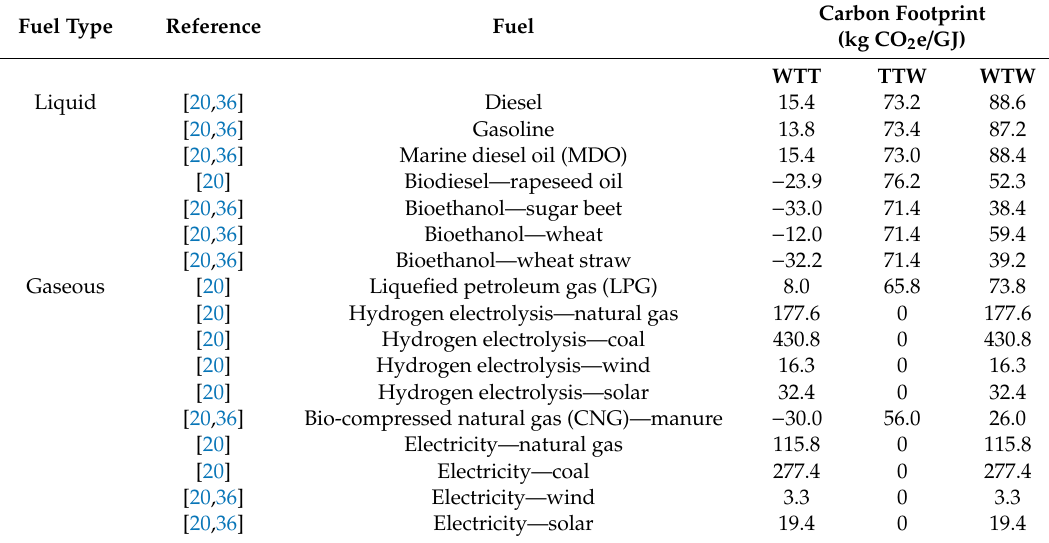
Table A1. Specific carbon footprints, including the well-to-tank (WTT), tank-to-wheels (TTW) and well-to-wheels (WTW) emissions. (Sources: JRC [20]; Turconi et al.